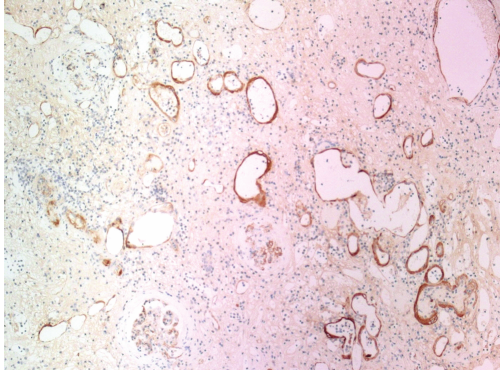
Figure 5: Fibrin microthrombi were also seen in the glomeruli (PAS × 200). Glomerulitis in the form of mononuclear inflammatory cells infiltrating the glomerular capillaries was seen (Inset PAS × 200).